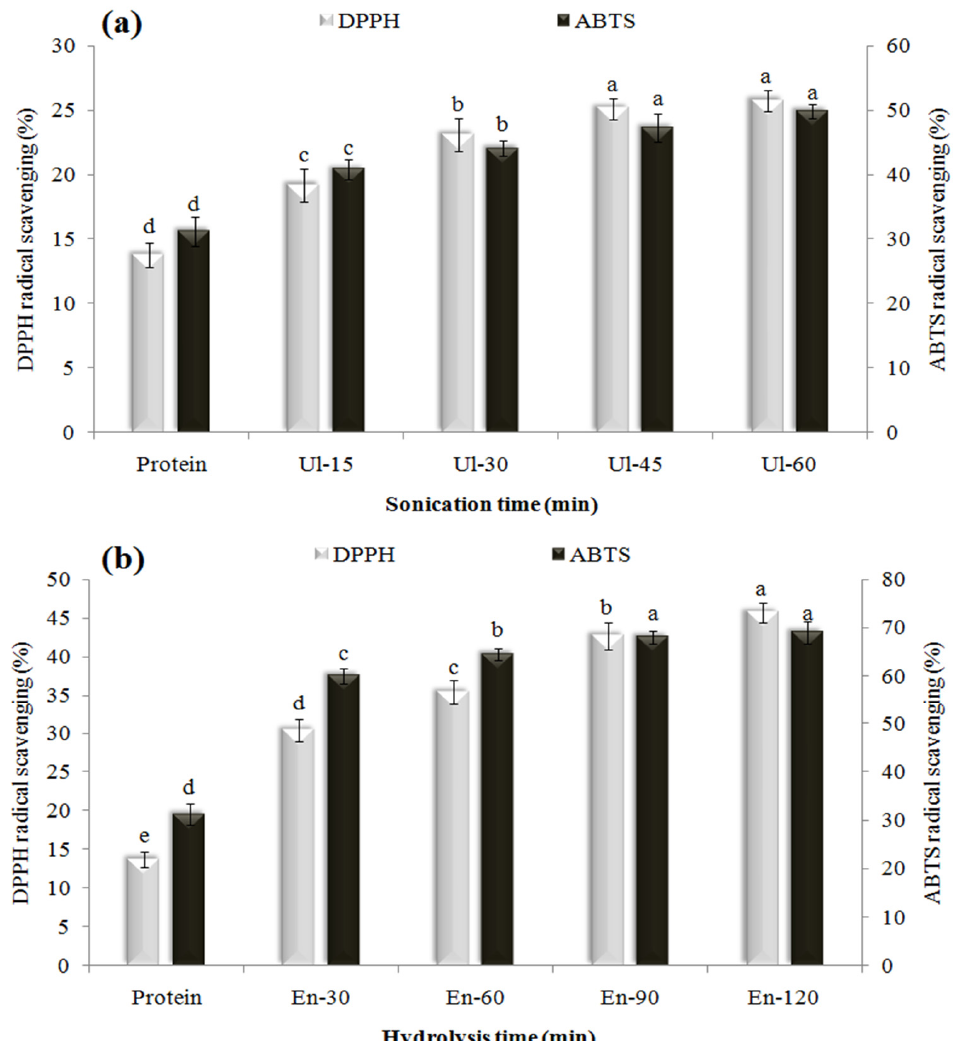
Figure 1. Effect of sonication time ( a ) or enzymolysis ( b ) on the DPPH and ABTS radical scavenging activity of WPC. Data are presented as mean ( n = 3) with standard deviation (the same letters above bars indicate that the differences between average values were statistically not significant p <0 .05).